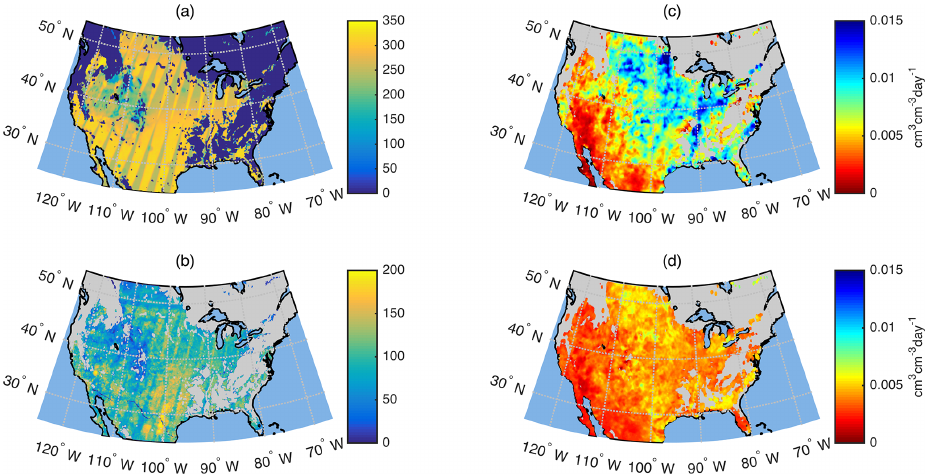
Figure 1. (a) Number of SMAP observations used in this study. (b) Number of drying rates calculated from SMAP observations and Noah simulations. (c) Median of SMAP drying rates. (d) Median of Noah drying rates. Drying rates are expressed as changes in volume per day (cm 3 cm − 3 day − 1 ) . Note that artifacts of SMAP’s orbital track are visible in (a) and (b)